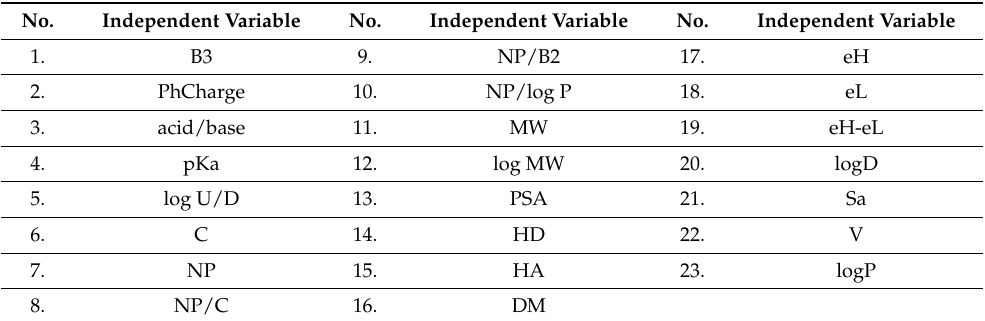
Table 3. Twenty-three independent variables with NP TLC data used to create the RF and PLS model for PB.